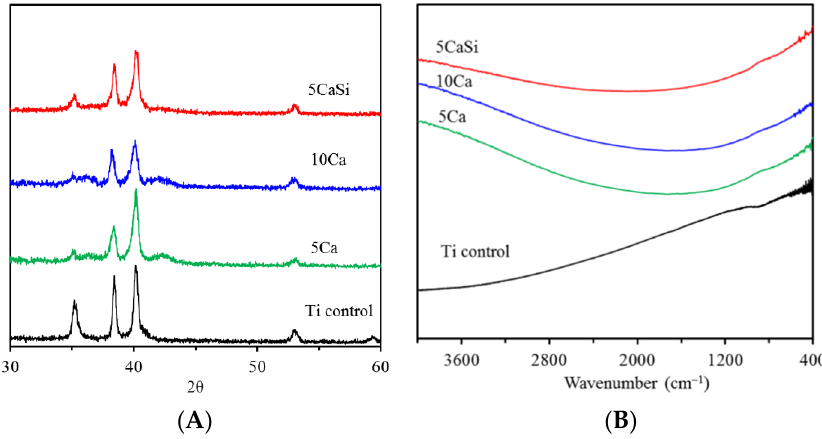
Figure 3. ( A ) Grazing incidence X ‐ ray diffractometer (GIXRD) patterns and ( B ) FTIR spectra of the Ti samples with and without ion implantation.